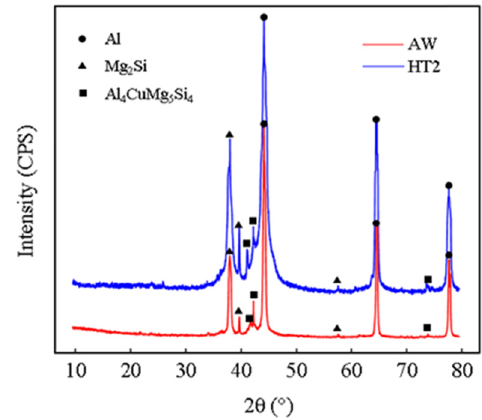
Figure 4: XRD patterns of weldment before and after